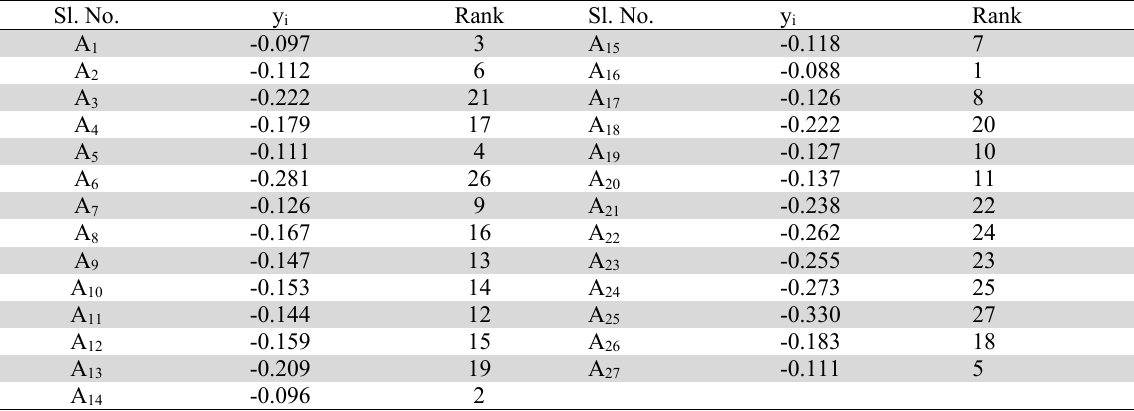
Overall assessment value by MOORA-PCA Sl.